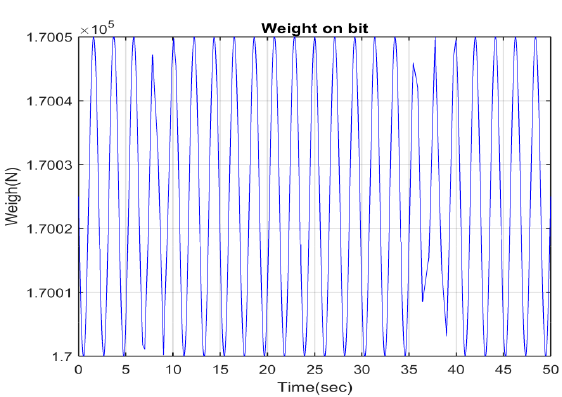
Figure 7. Weight on bit variation.